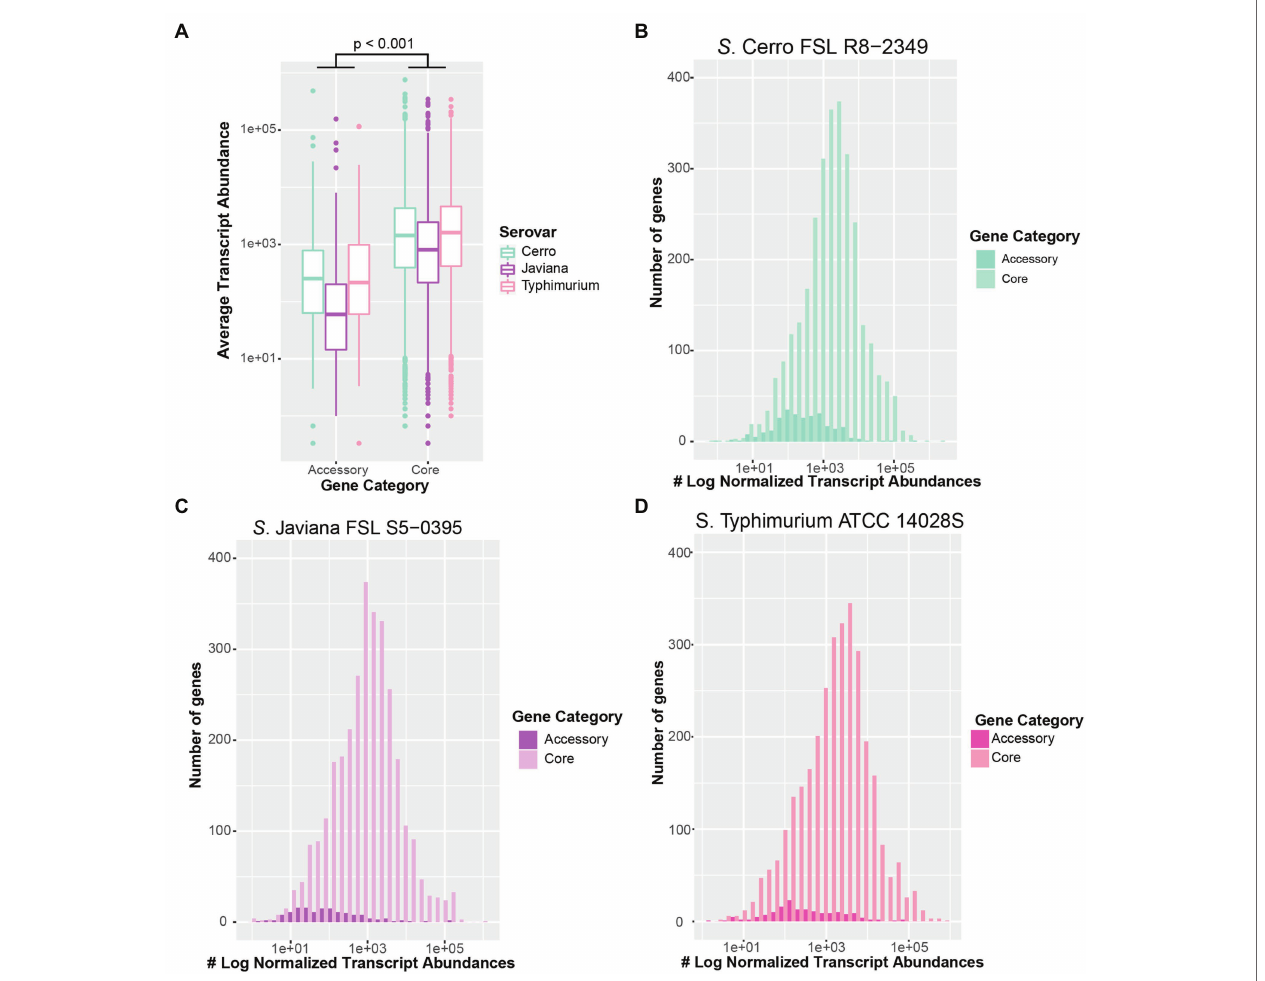
FIGURE 2 | Transcript abundances of core genes are significantly higher than accessory genes in all three serovars. (A) Boxplot of average transcript abundances of core and accessory genes from three independent replicates of S. Cerro FSL R8-2349, Javiana FSL S5-0395, and Typhimurium ATCC 14028S cultured to late exponential phase in LB broth at 37 ° C. Significance was assessed with ANOVA after fitting a linear mixed-effects model to transcript abundances data and calculating the least square-means. Histograms of average transcript abundances of core (light colors) and accessory genes (dark colors) in (B) S . Cerro FSL R8- 2349 , (C) S. Javiana FSL S5-0395, and (D) S. Typhimurium ATCC 14028S. Results represent the average of three independent replicates. Core and accessory genes of 16 isolates per serovar were defined using Roary (Page et al.,